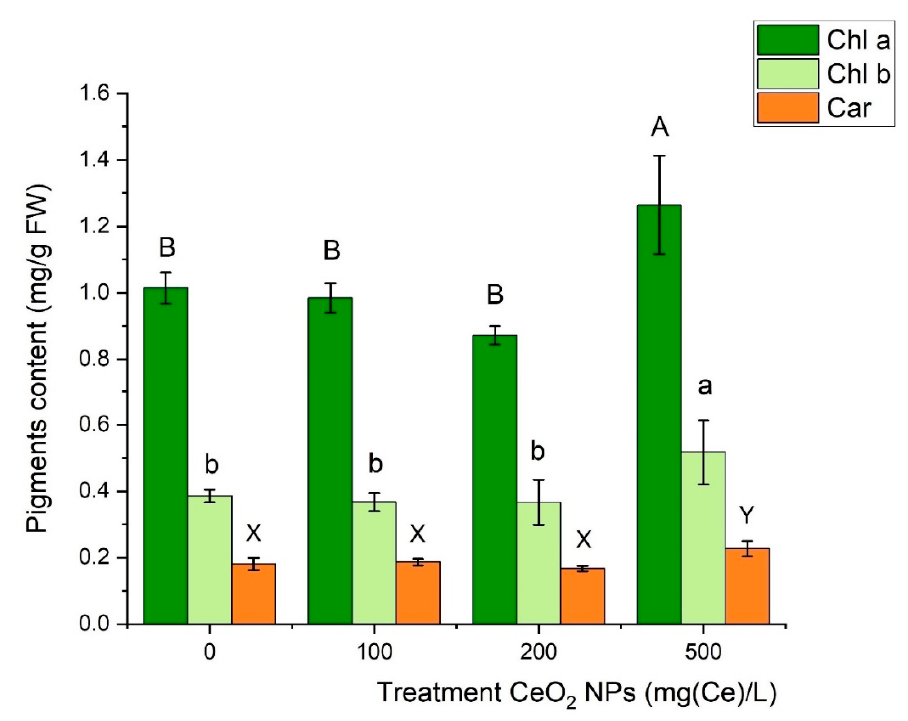
Figure 2. Contents of chlorophyll a (Chl a), chlorophyll b (Chl b), and carotenoids (Car) in green pea cultivated in Hoagland solutions supplemented with CeO 2 NPs. All pigments were extracted from mature leaves. Distinct letters indicate statistically significant differences as evaluated by the Tukey’s post hoc test ( α = 0.05).